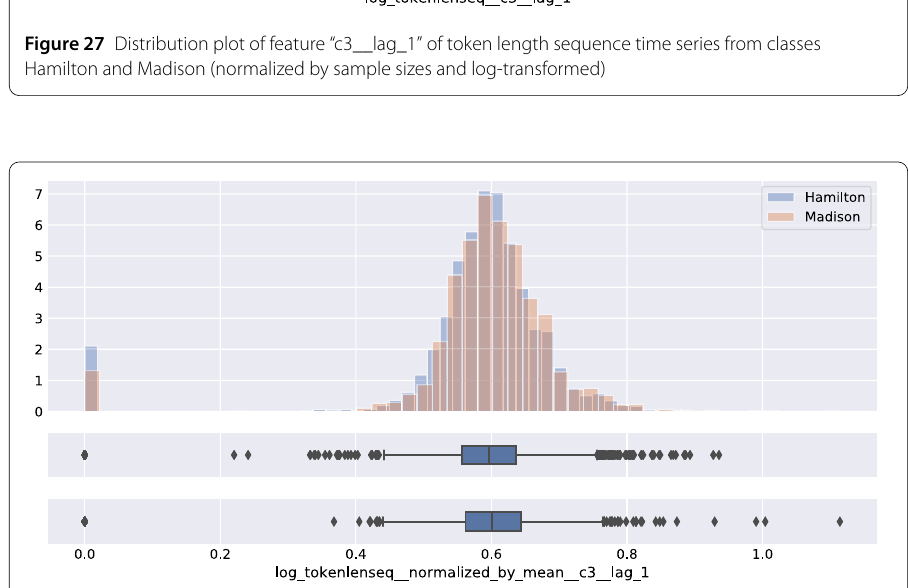
Figure 28 Distribution plot of the normalized-by-mean feature “c3__lag_1” of token length sequence time series from classes Hamilton and Madison (normalized by sample sizes and log-transformed)